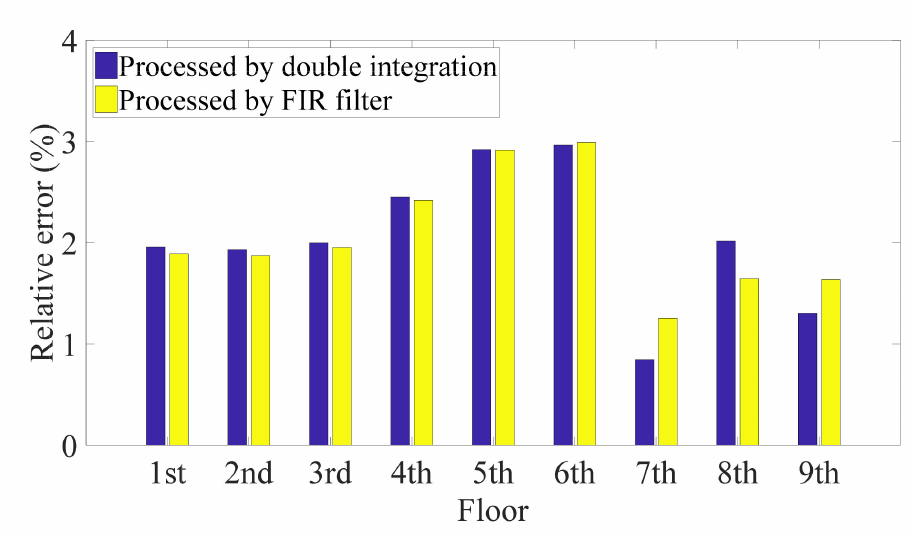
Figure 5. Relative error of maximum inter-story drift of nine-DOF